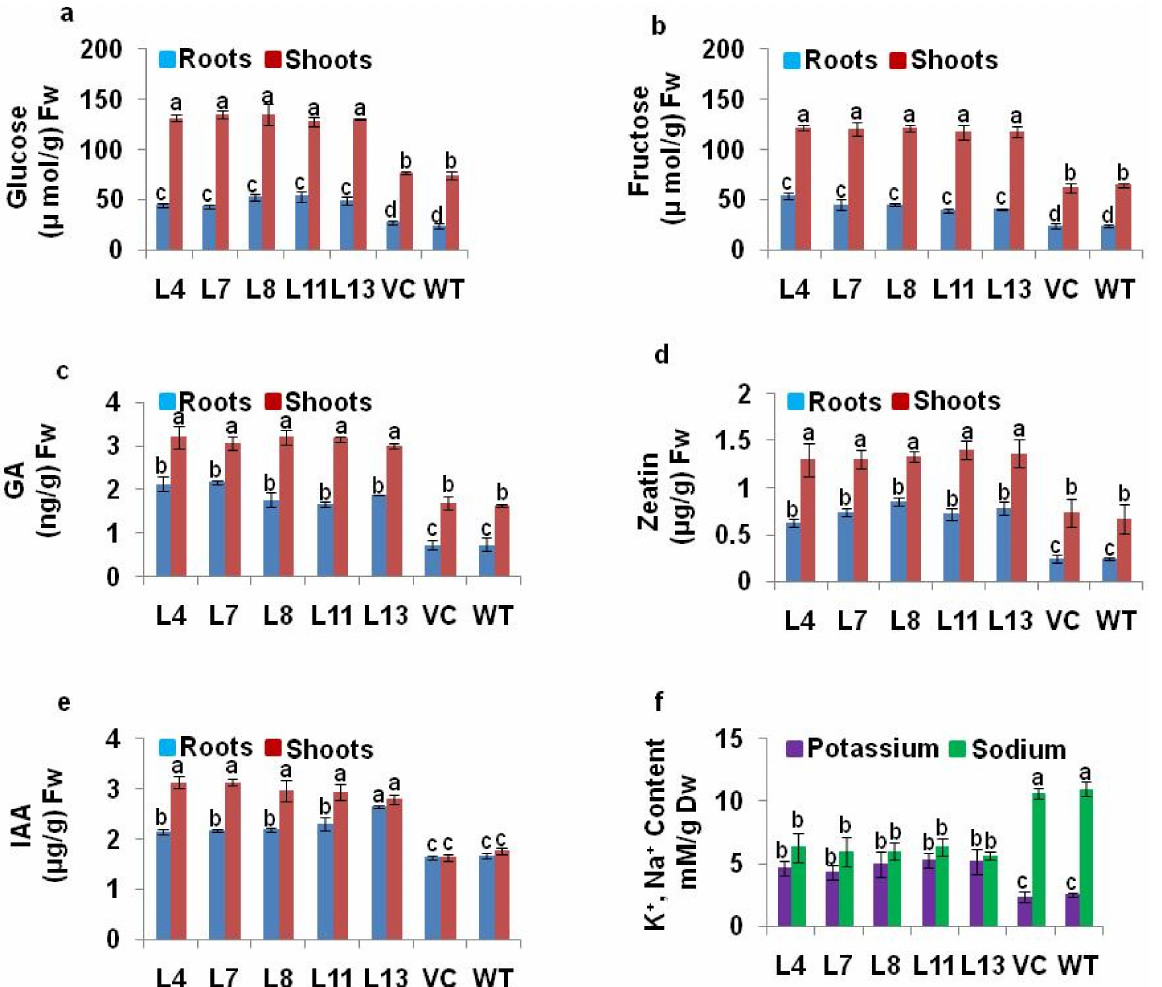
Figure 5. Soluble sugar, hormones, and K + and Na + content in the roots and shoots of PDH45 - overexpressing marker-free transgenic lines (L4, L7, L8, L11 L13) as compared to WT and VC plants exposed to 24 h at 200 mM NaCl treatment. ( a ) Glucose content. ( b ) Fructose content. ( c ) Endogenous GA content. ( d ) Endogenous zeatin content. ( e ) Endogenous IAA content. ( f ) Endogenous potassium and sodium content. Values are mean ± SE ( n = 3). Different letters on the top of bars indicate significant differences at p ≤ 0.05 level as determined by Duncan’s multiple range test